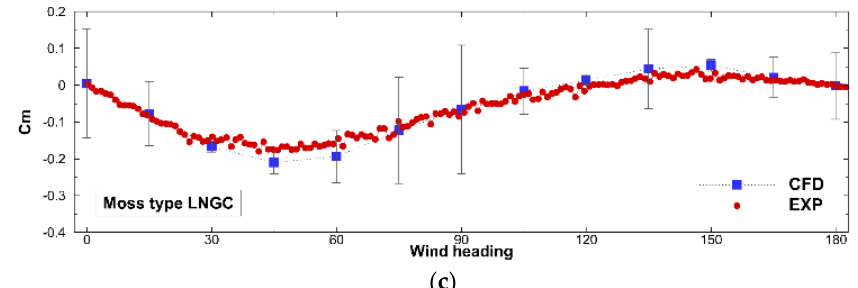
Figure 13. Comparison of aerodynamic coefficients for the moss-type LNGC. ( a ) C x ; ( b ) C y ; ( c ) C m .